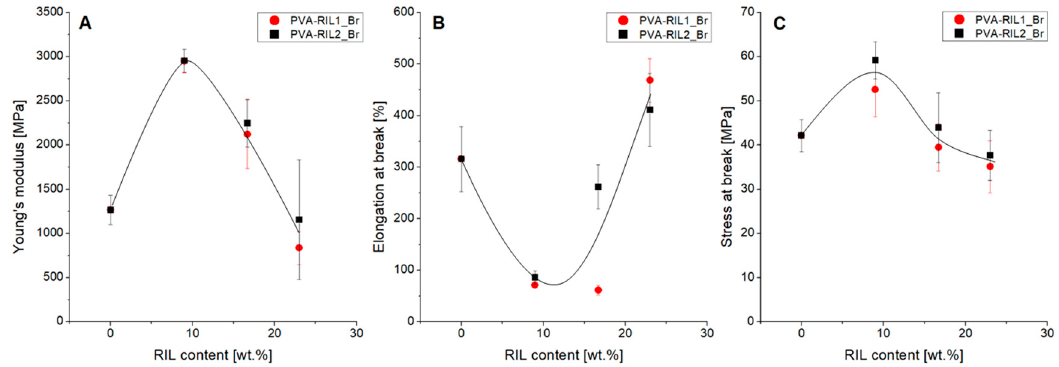
Figure 11. Mechanical properties of PVA-RIL films as a function of RIL content.